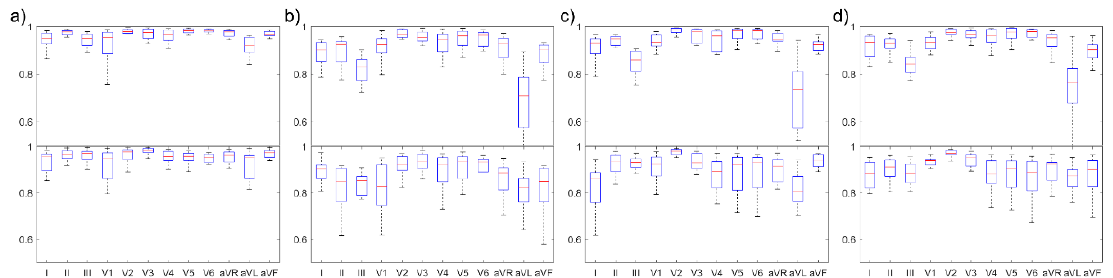
Figure 6. CCs of each reconstructed 12-lead ECG signal at the location that showed the highest CC: ( a ) all combinations, ( b ) 5 × 5 square, ( c ) 10 × 10 square, and ( d ) right-angled triangle. The red line indicates the median value. (upper column: CCmean approach, lower column: CCmin approach). Table 4. CC, RMSE and R ‐ square values of each 12 ‐ lead ECG for the meanCC approach with the ANN model.